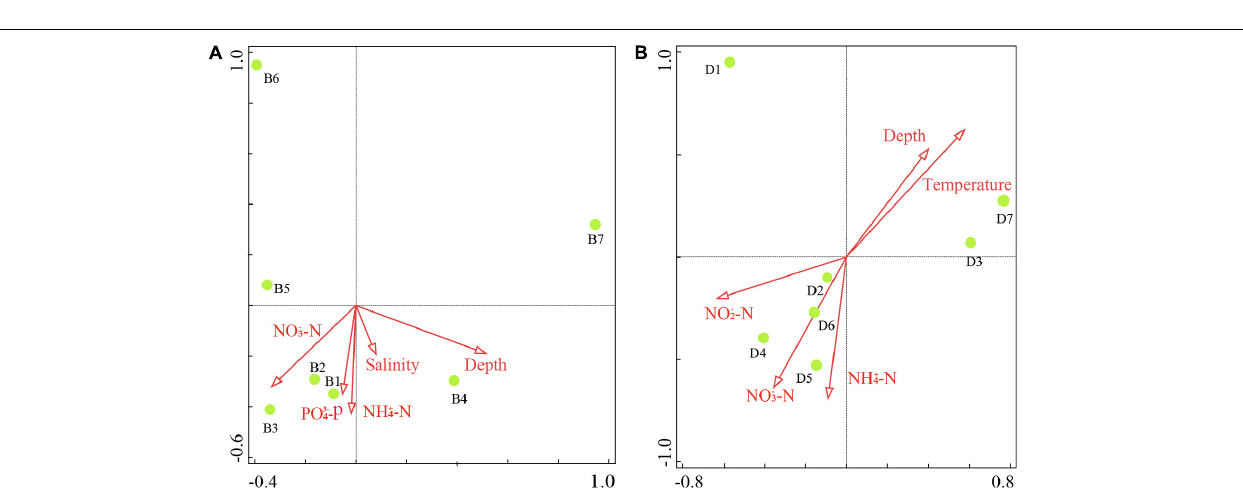
FIGURE 7 | Redundancy analysis of the major environmental factors affecting fish species (obtained through bottom trawling) in (A) summer and (B) winter in the Zhoushan Sea (China).